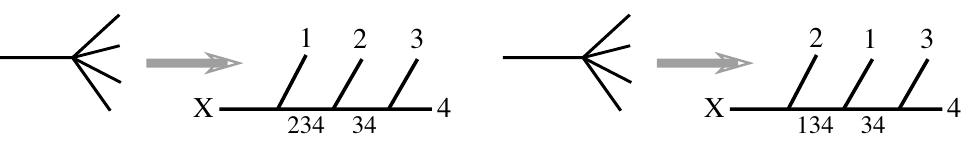
Figure 4: Two decompositions of a 4-particle decay into 2-particle decay chains for the definition of various kinematic